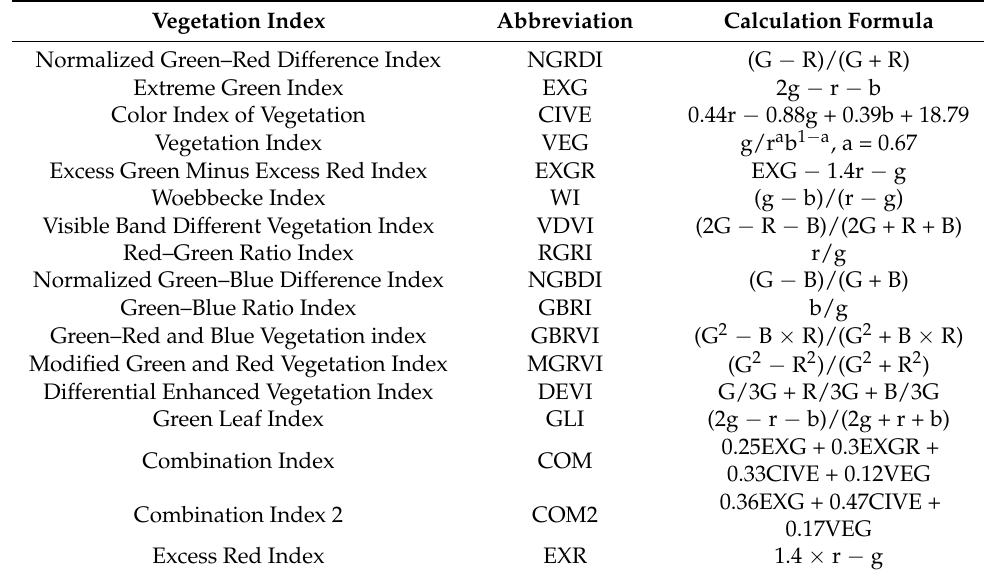
R: red light channel. G: green light channel. B: blue light channel. r: standardized results for the red light channel, r = R/(R + G + B). g: standardized results for the green light channel, g = G/(R + G + B). b: standardized